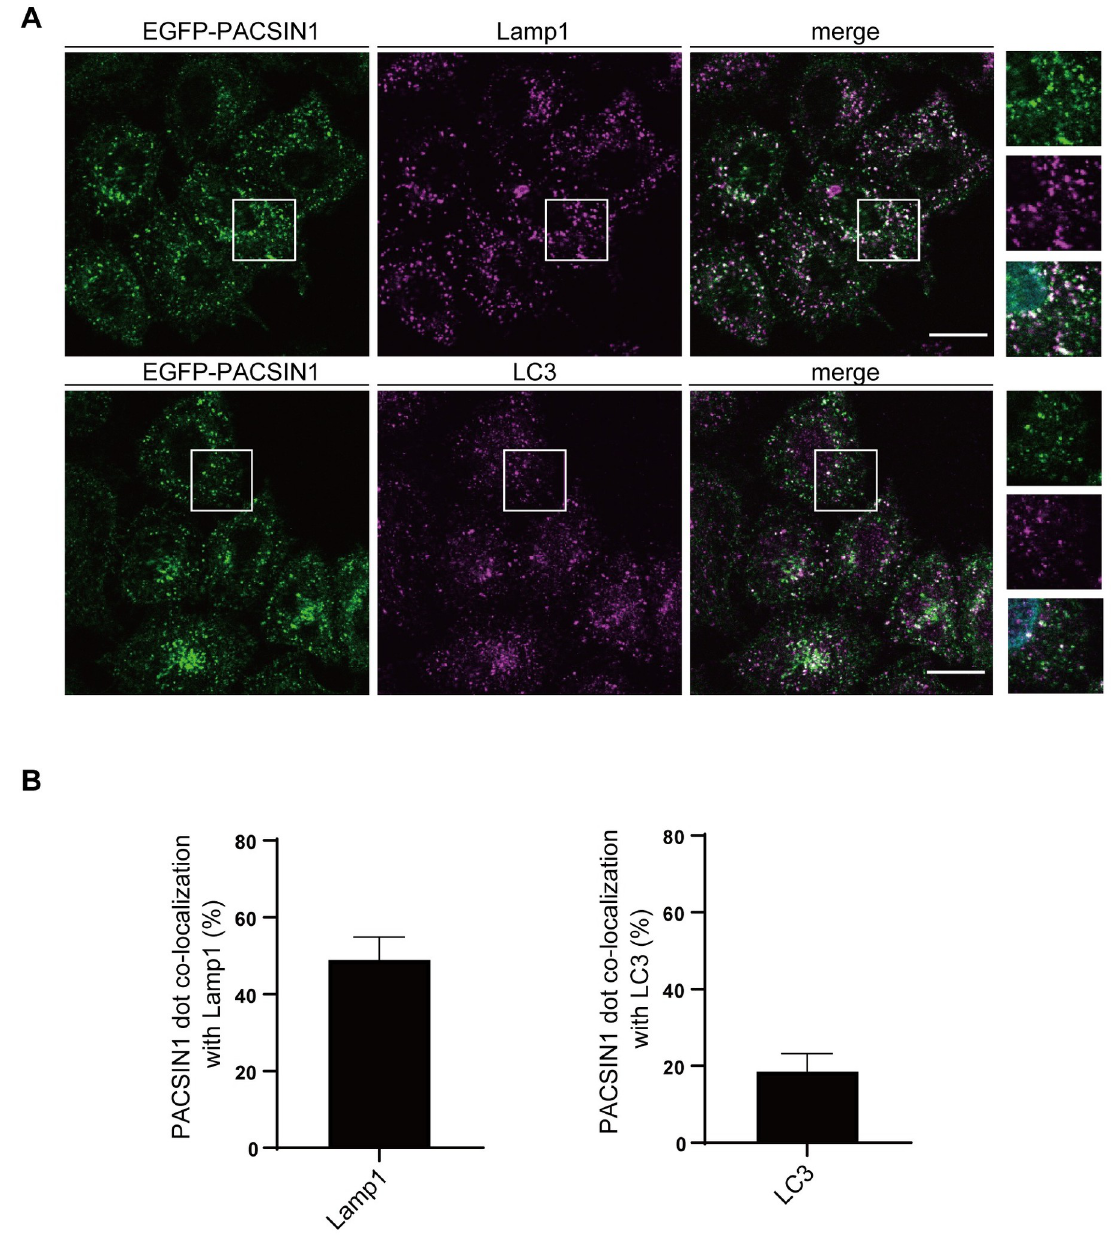
Fig 4. PACSIN1 localizes to both autophagosomes and lysosomes. (A) WT HeLa cells stably expressing EGFP-PACSIN1 were cultured for 2 h in growth medium with 125 nM Baf.A1. Cells were pre-treated with 0.05% saponin and fixed. Cells were then stained with anti- LC3 or anti-Lamp1 antibodies, and analyzed by confocal microscopy. Scale bars, 20 μ m. (B) The co-localization rate of PACSIN1 with Lamp1 or LC3 was quantified by Fiji, mean ± s.e.m. More than 200 cells were analyzed per condition in each experiment (n =